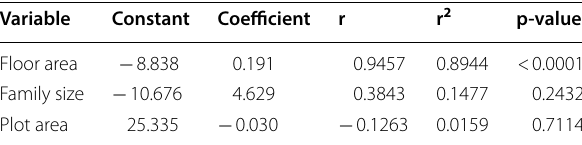
Table 4 Result of simple regression analysis of EF on the three predictor variables